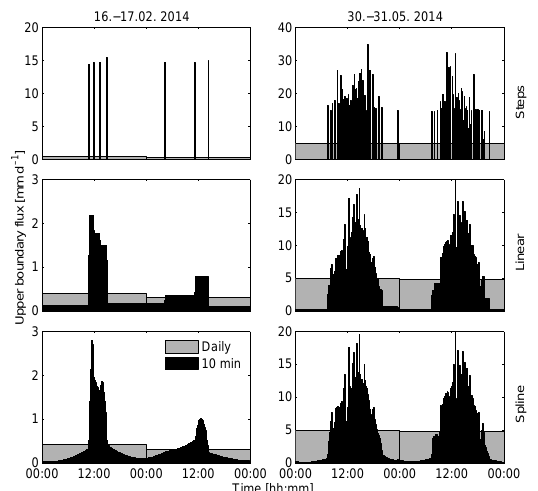
Figure 3. Derived potential evapotranspiration rates from data shown in Fig. 2 with temporal resolutions of 1 day or 1h, re- spectively. Steps: original step interpolation scheme; linear: linear interpolation scheme; spline: cubic Hermitian spline interpolation scheme.